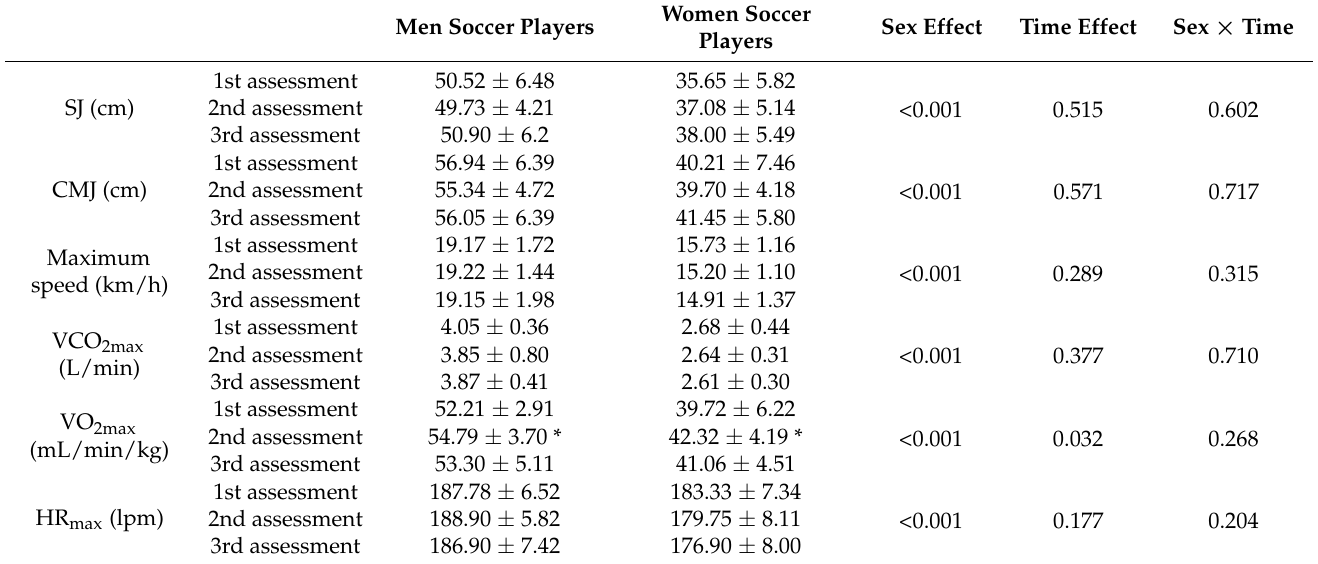
Table 5. Results obtained in the vertical jump and in the maximum incremental test of the participants.